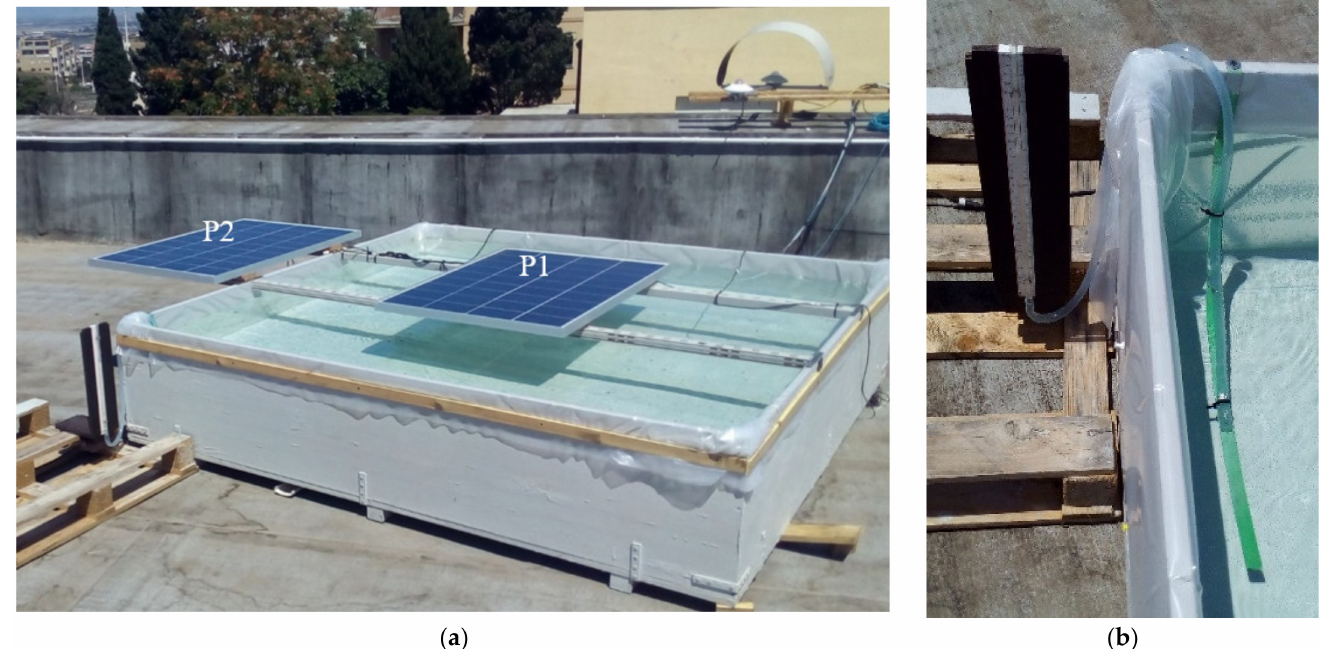
Figure 1. ( a ) PV Panel P1 placed above water surface, whereas the Panel P2 placed at ambient condition; ( b ) Water evaporation measuring